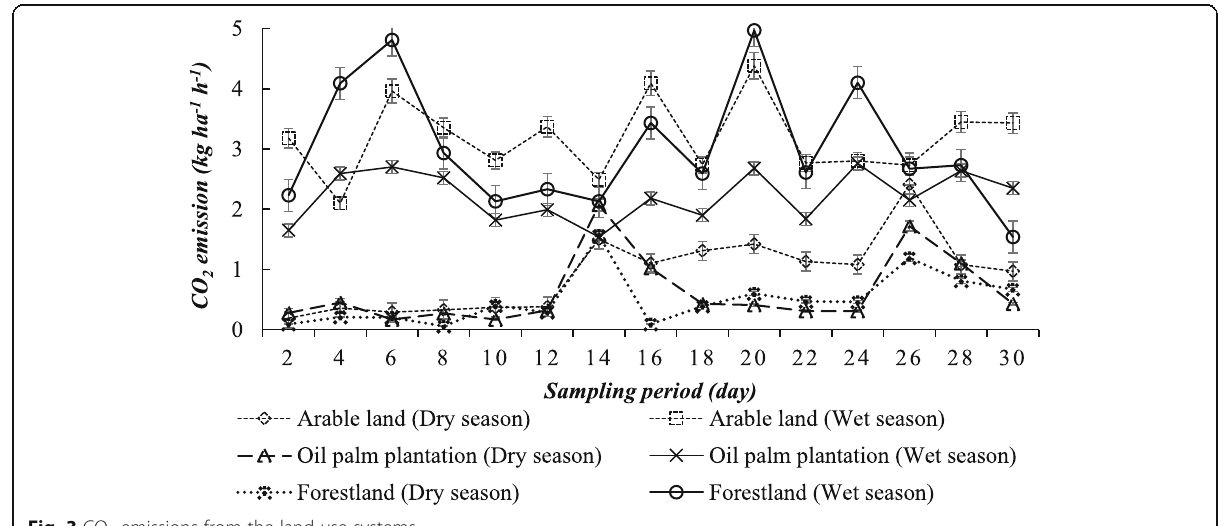
Fig. 3 CO 2 emissions from the land use